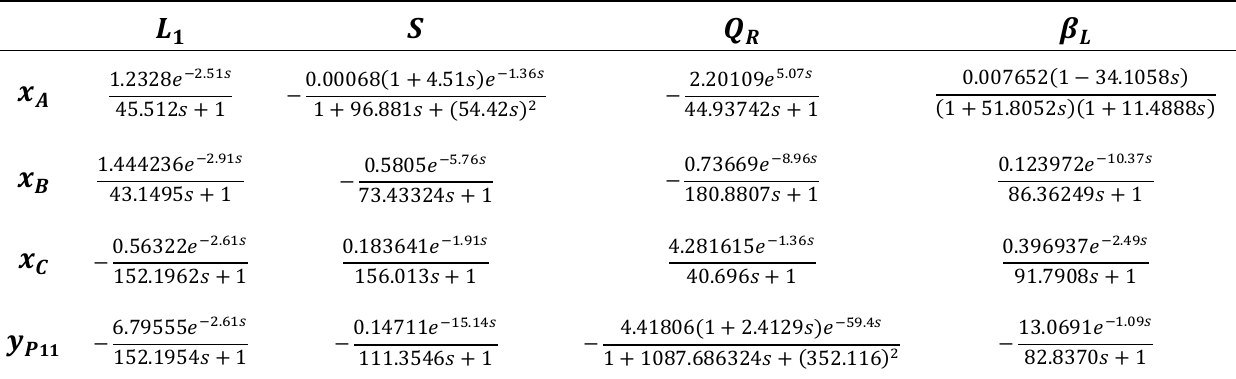
Table 2. Transfer function matrix for DB stabilization.